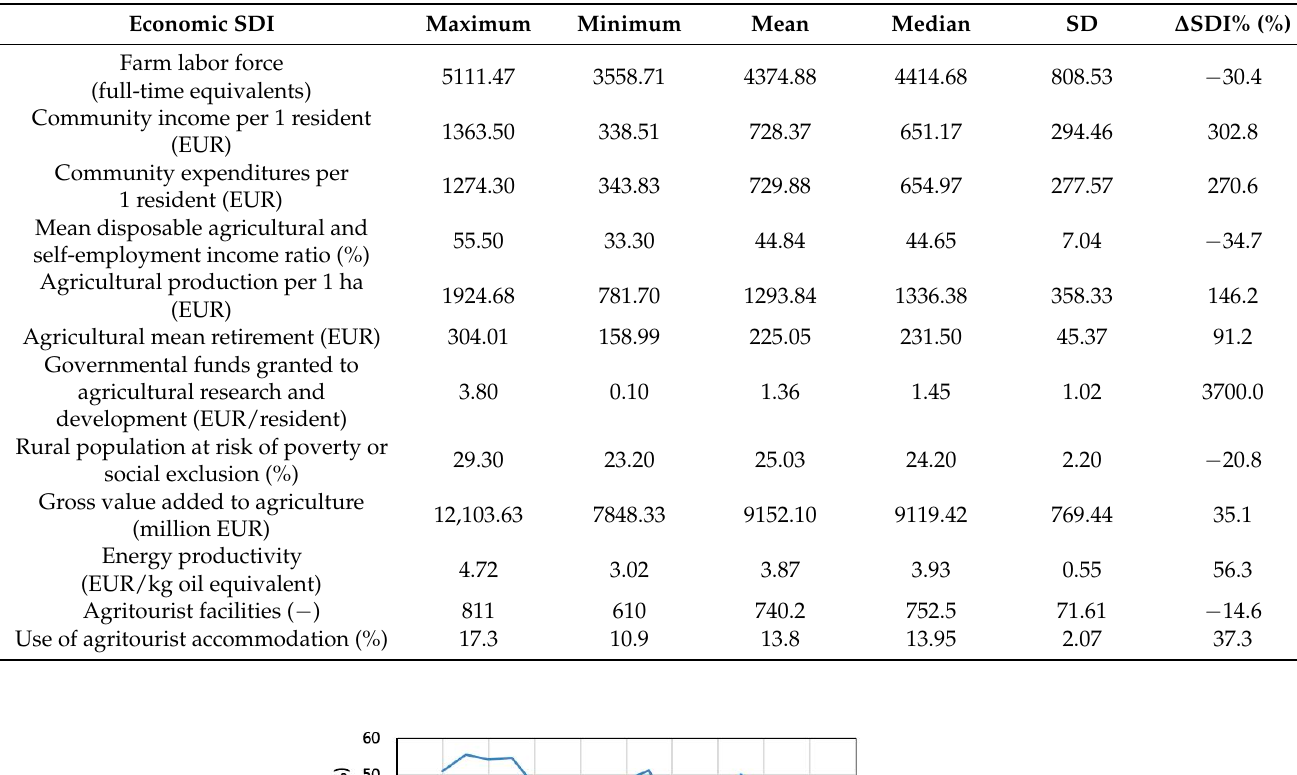
Table 4. Characteristics of studied economic Sustainable Development Indicators.